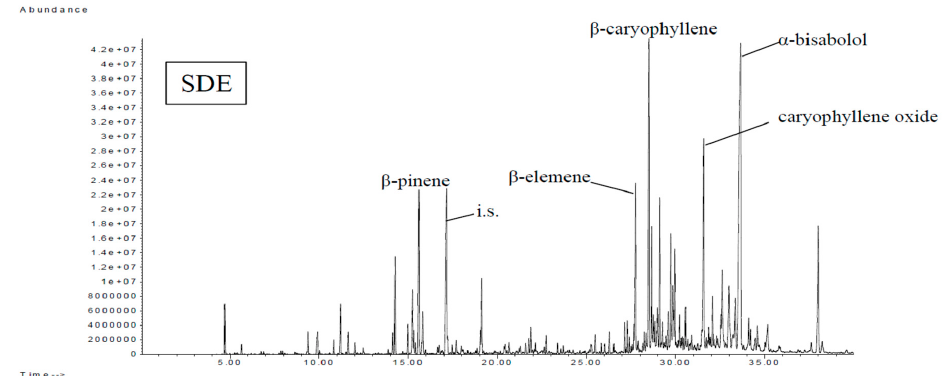
Figure 5. Total ion chromatogram of volatile components of Nongshi No. 1 determined using SDE.